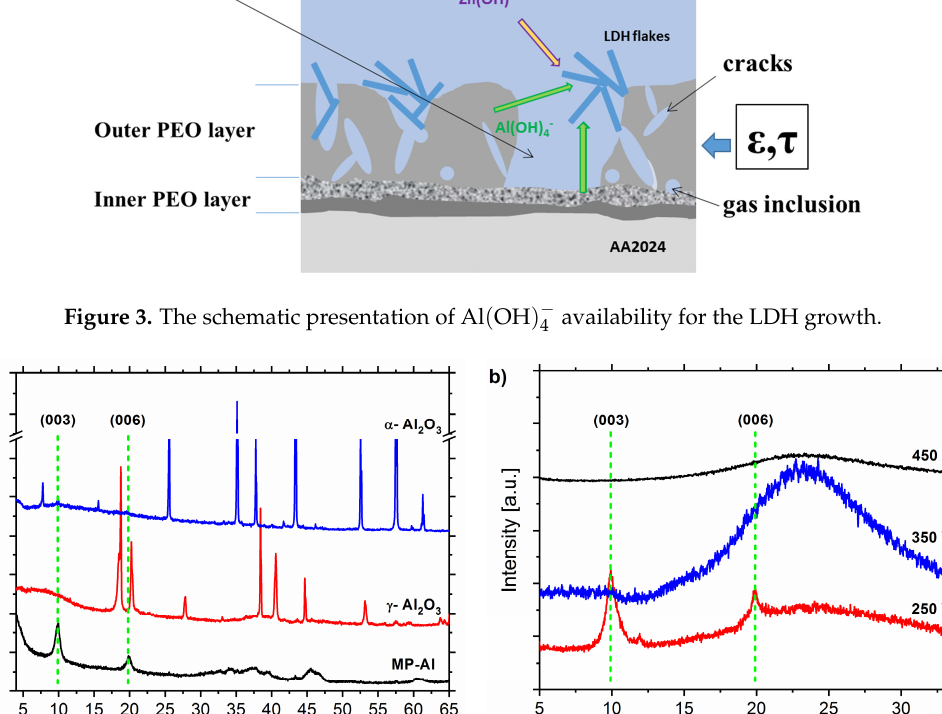
Figure 4. ( a ) X ‐ ray diffraction patterns of the metallic powder Al (MP ‐ Al), γ‐ Al 2 O 3 , and α‐ Al 2 O 3 after Figure 4. ( a ) X-ray diffraction patterns of the metallic powder Al (MP-Al), γ -Al 2 O 3 , and α -Al 2 O 3 after attempting to grow LDH ‐ NO 3 on them; and ( b ) AA2024 alloy with PEO formed at 250 V, 350 V, and attempting to grow LDH-NO 3 on them; and ( b ) AA2024 alloy with PEO formed at 250 V, 350 V, and 450 V after attempting to grow LDH ‐ NO 3 . 450 V after attempting to grow LDH-NO 3